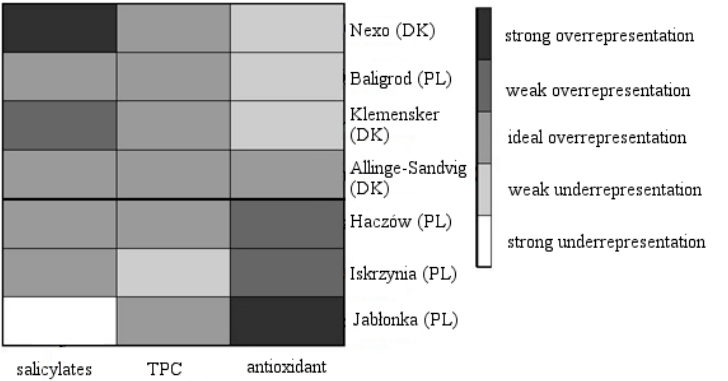
Figure 4. Overrepresentation maps for analyzed objects. Strong (under) overrepresentation indicates (lower) higher value in relation to mean value of analyzed variable. Source: own preparation.